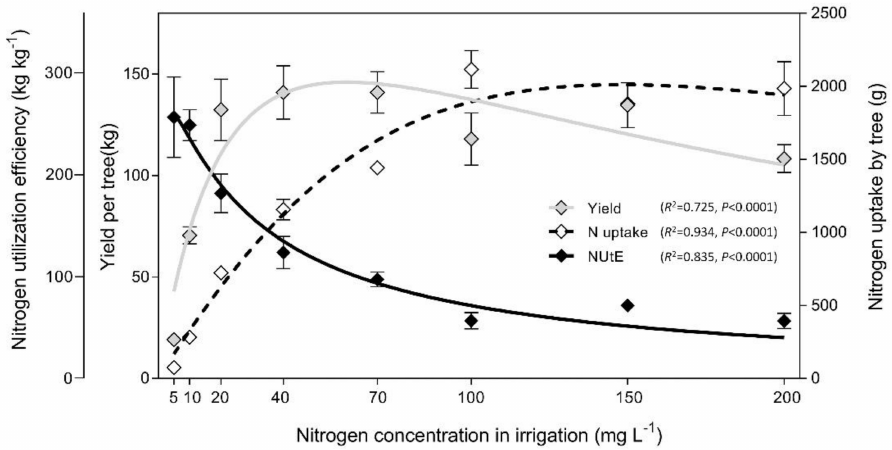
Figure 5. The e ff ect of nitrogen levels on yield, N uptake and N utilization e ffi ciency of pomegranates over two years (a combination of 2017 and 2018). Bars represent SD. Regression equations and statistics are presented in Table A1. Significance between treatments is presented in Table